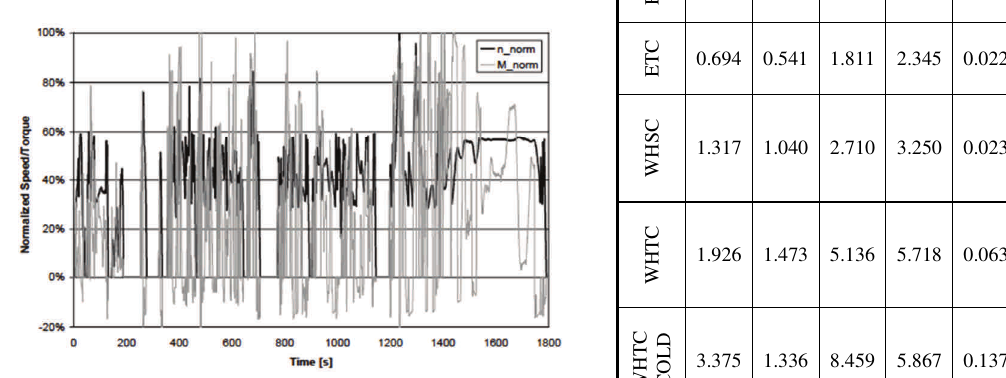
Fig. 6. Scheme of standardized WHSC cycle and coefficients participation phase [6]